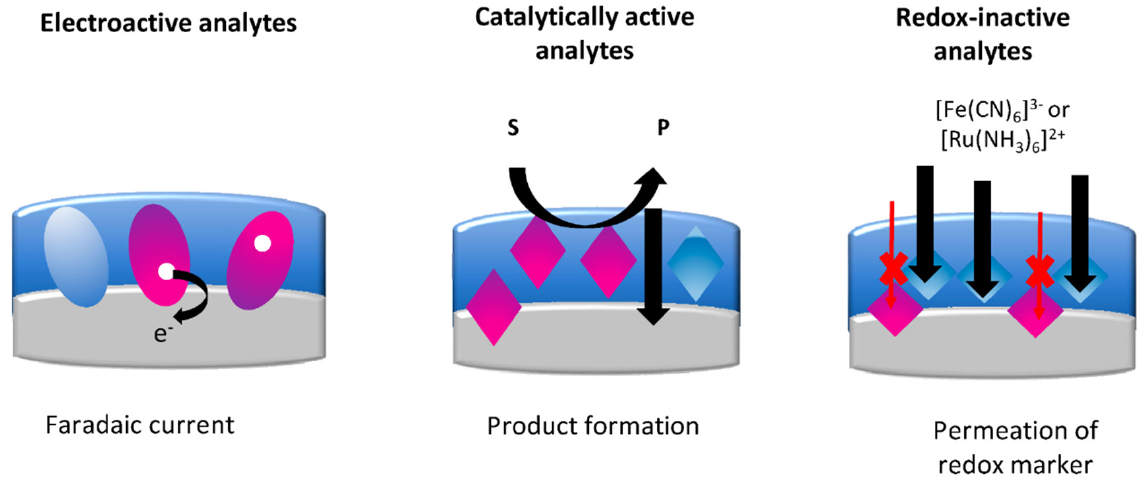
Figure 10. Three main approaches for achieving the electrochemical readouts of MIP ‐ based sensors: a direct electron transfer ( left ), enzymatic activity ( center ), and the flux of a redox probe ( right ).